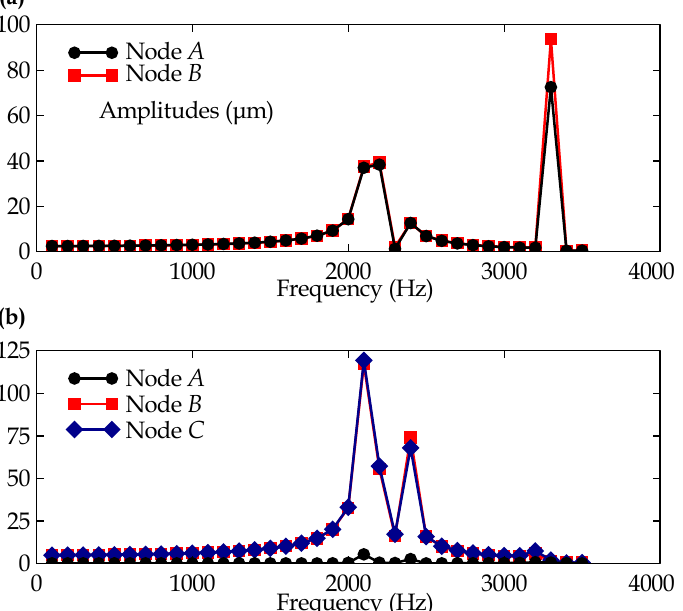
Figure 9. Harmonic responses of proposed 2-DOF decoupled stage. ( a ) y -direction deformation in y -axis actuation. ( b ) y -direction deformation in x and y -axis